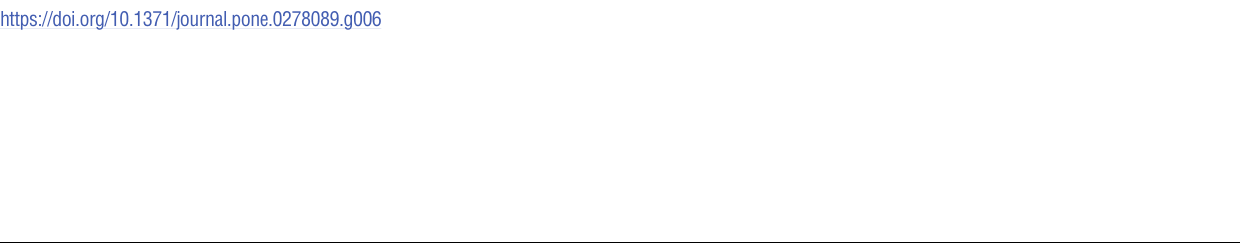
PLOS ONE | https://doi.org/10.1371/journal.pone.0278089 November23,